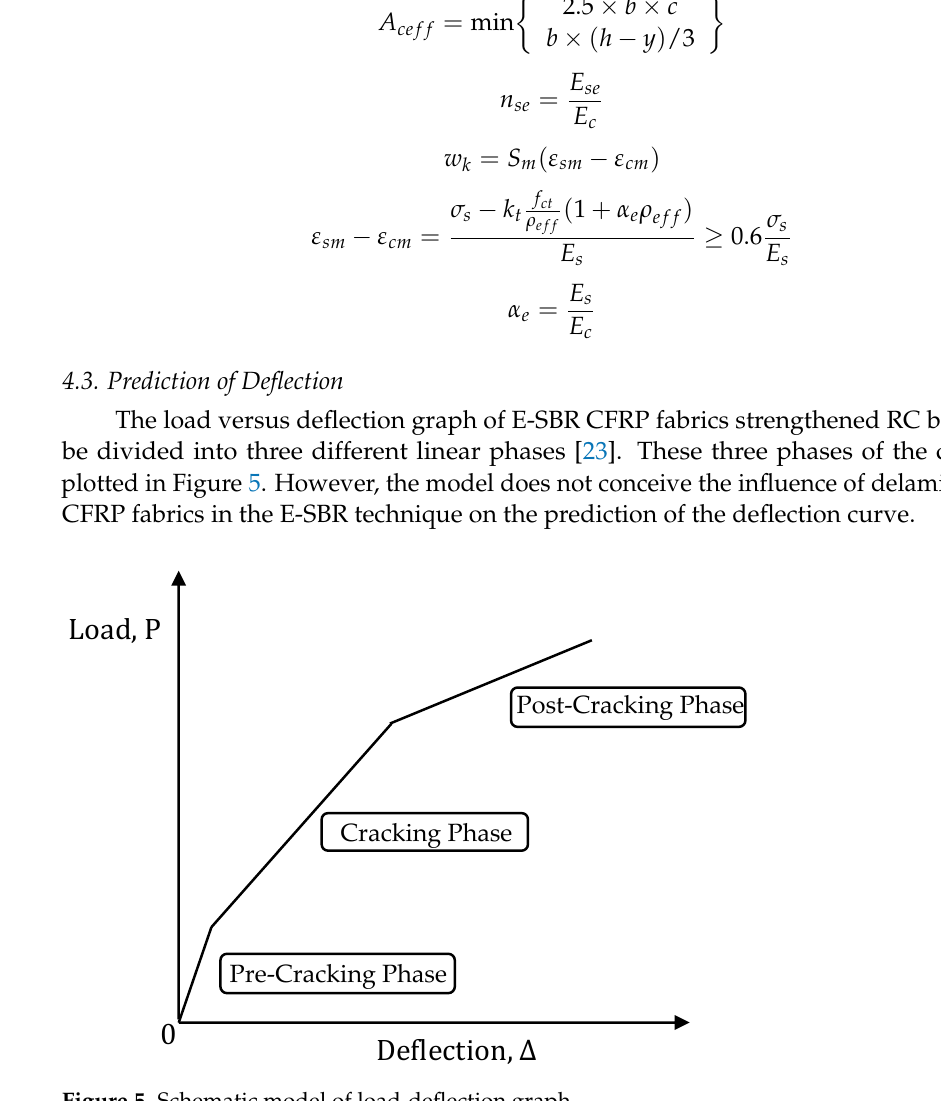
Figure 5. Schematic model of load-deflection graph.